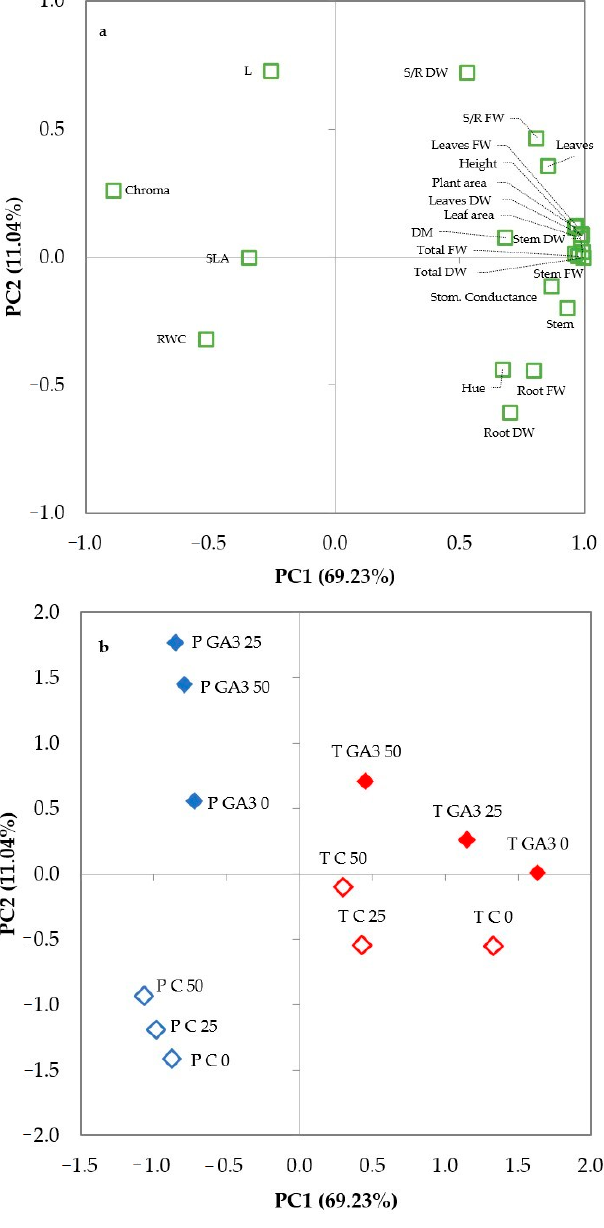
Figure 10. Plots of ( a ) loadings (morphophysiological characteristics of tomato and sweet pepper seedlings) and ( b ) scores (trials) formed by the two principal components from the Principal Component Analysis (PCA). T C: untreated tomato seedlings; T GA3; tomato seedlings spayed with 10 − 5 M of gibberellic acid (GA 3 ); P C: untreated pepper seedlings; P GA3: pepper seedlings spayed with 10 -5 M GA 3 ; 0, 25, and 50: concentration of NaCl (mM) in the irrigation water.